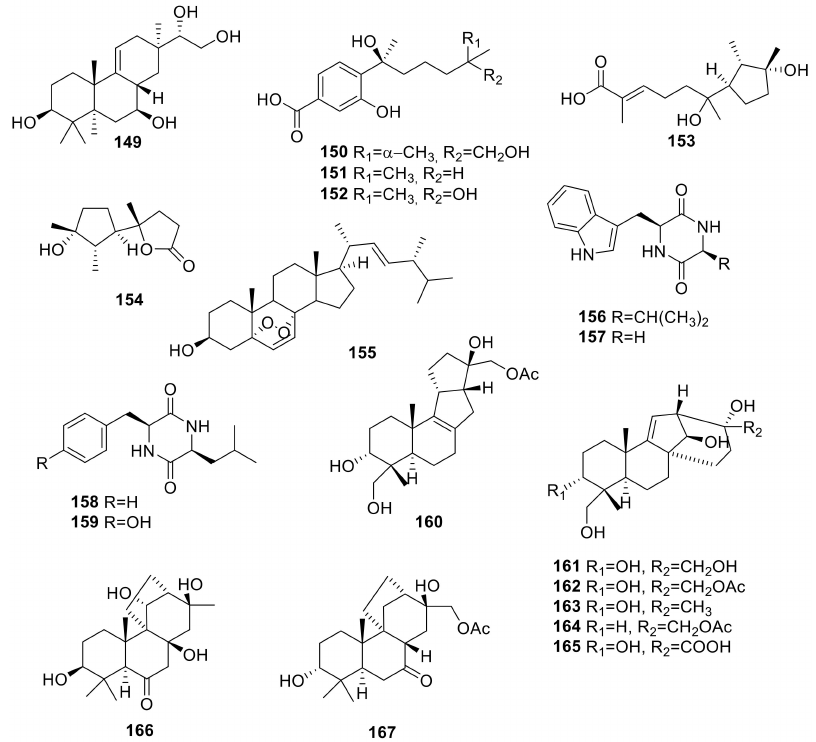
Figure 21. Structure of compounds 149-167